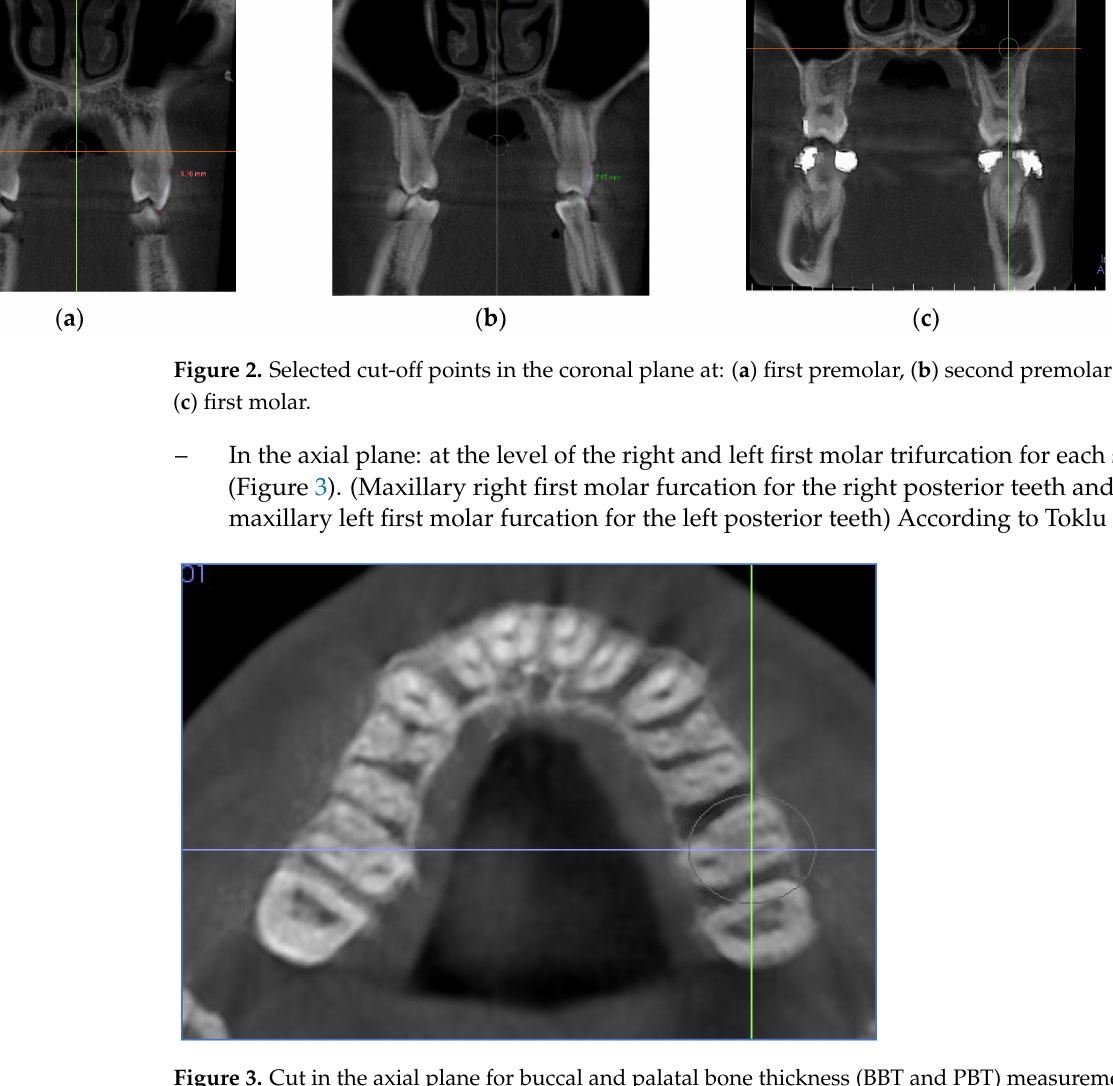
Figure 3. Cut in the axial plane for buccal and palatal bone thickness (BBT and PBT)